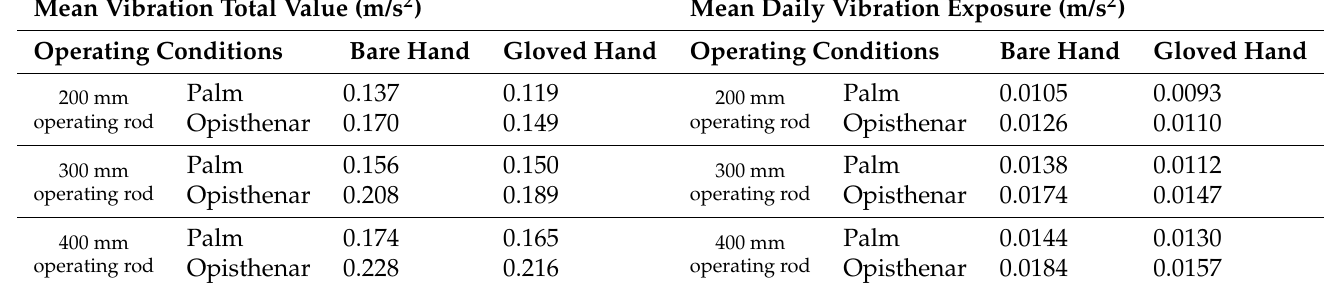
Table 2. Mean vibration total value of tightening and mean daily vibration exposure in composite state of power tool.